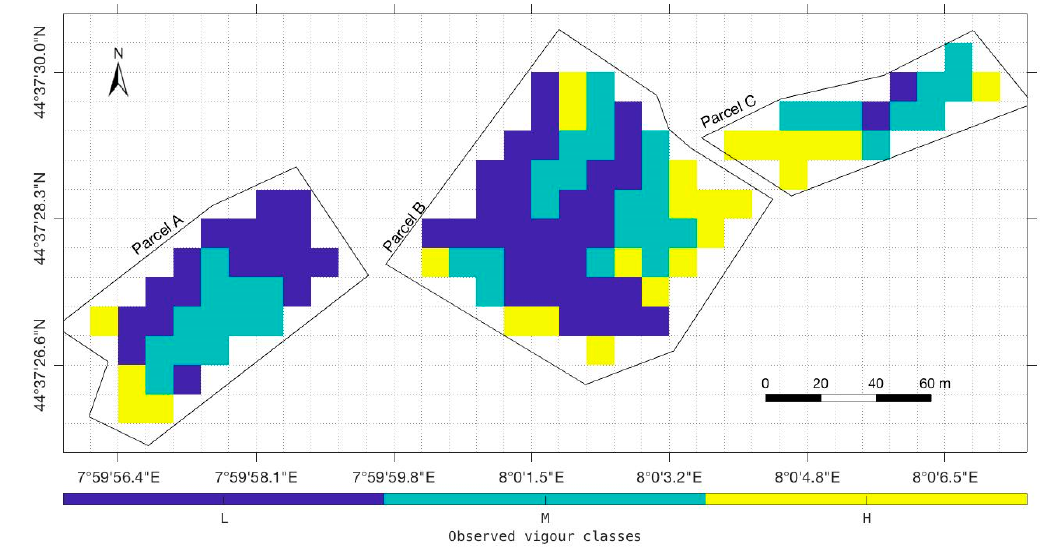
Figure 7. Vineyard test site classification into three vigour classes on the basis of the observed in-field